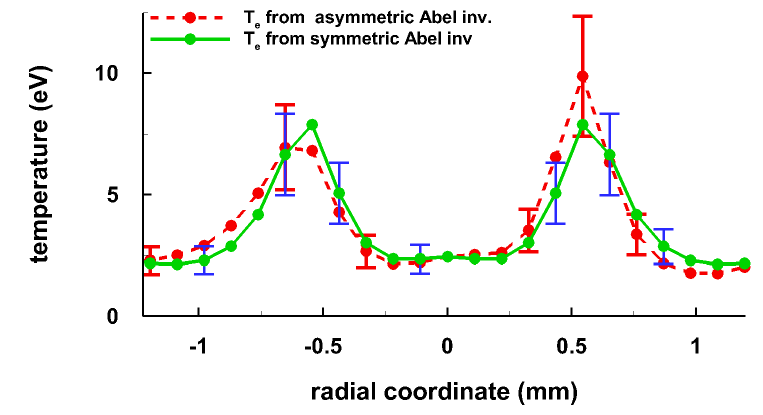
Figure 4. Electron temperature, T e , vs. radial position [15].